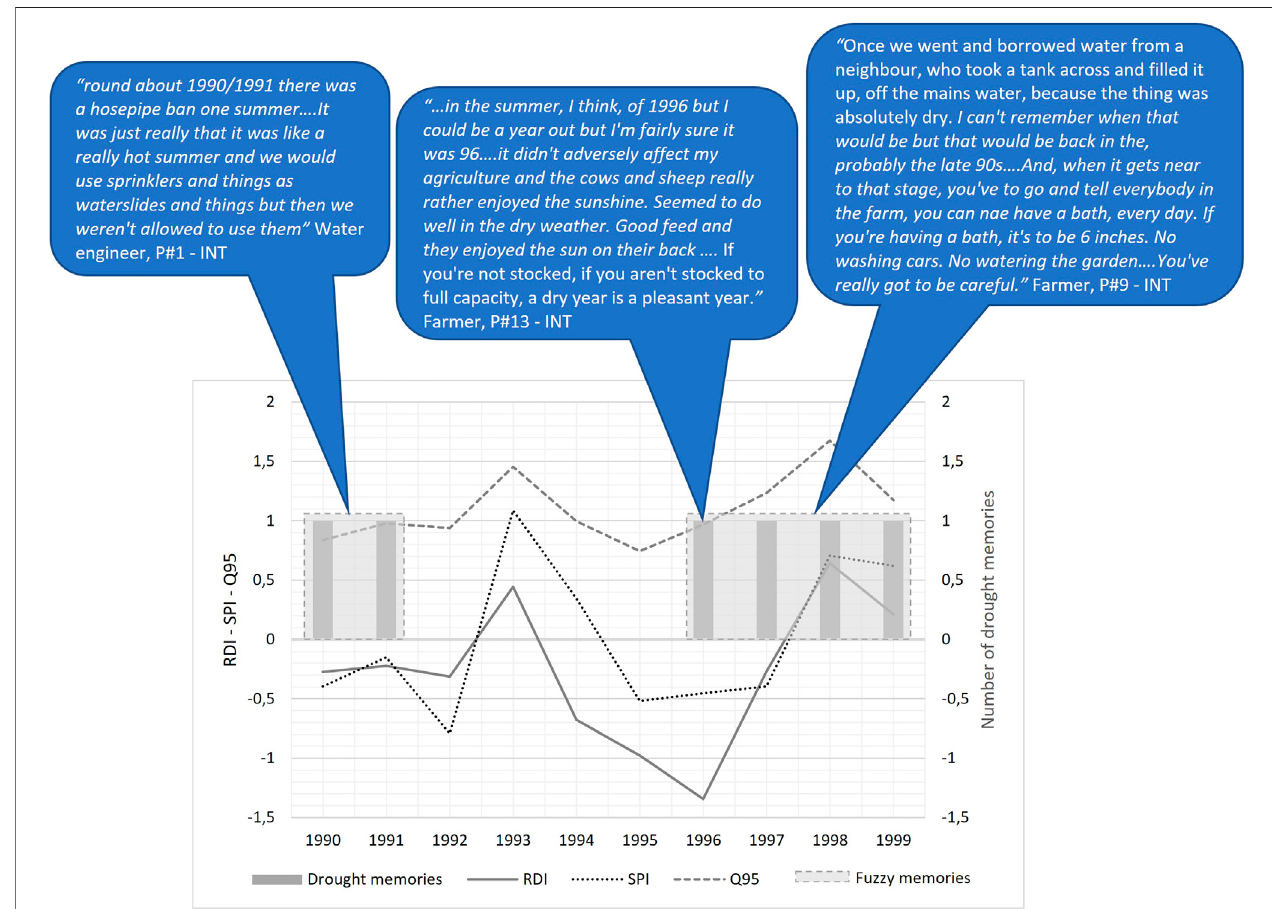
FIGURE 10 | Drought memories overlaid on RDI, SPI and Q 95 data for the decade 1990 to 1999.